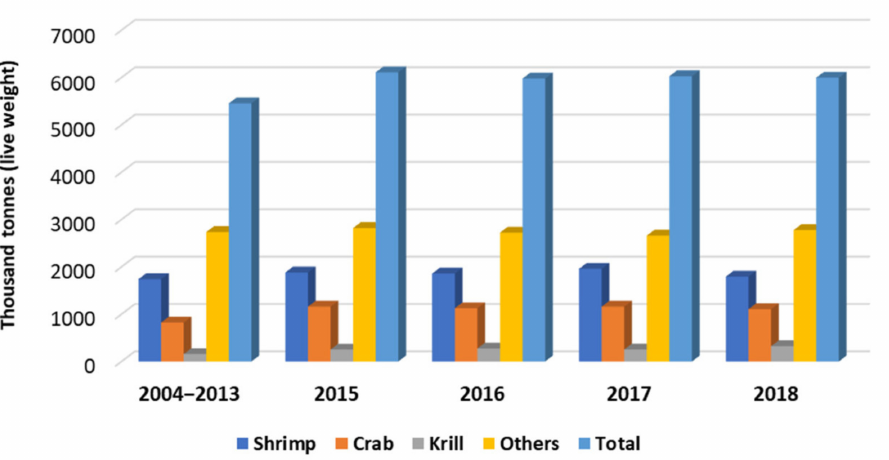
Figure 1. Major types of marine crustaceans globally produced by capture over the last two